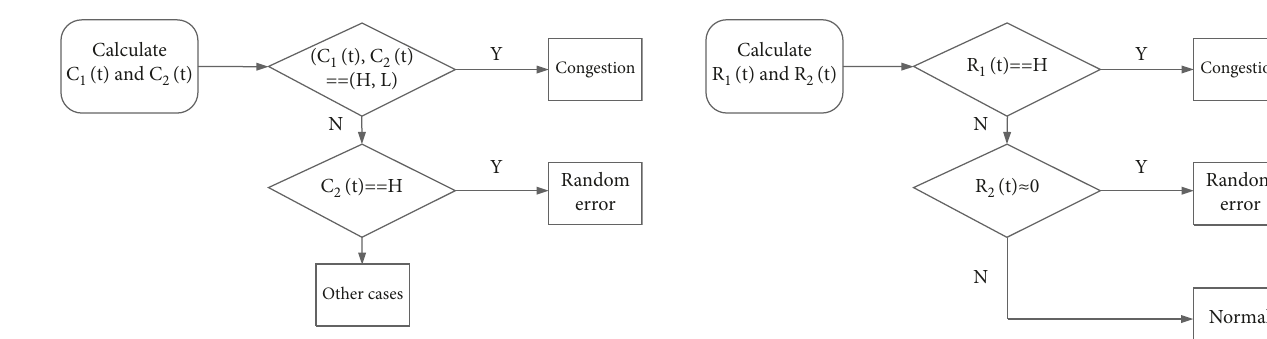
Figure 1: Congestion parameter feedback network